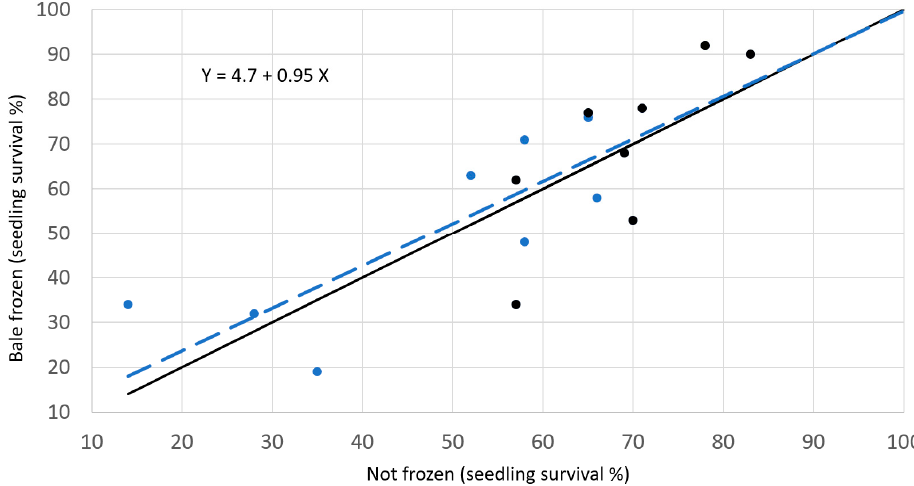
Figure 31. Seedling survivals for genetically unimproved bareroot loblolly pine packed into bundles (2000 seedlings per bail) in January of 1970 at the New Kent nursery in Virginia. Data from [197]. Bales were naturally frozen ( − 11 to − 12 ◦ C) outdoors on January 19 and 20 (blue dots), or February 1 to 3 (black dots). Frozen seedlings were thawed in an unheated building (beginning 23 January or 8 February) and outplanted 34 to 48 days after lifting. When planted in February, survival averaged 69%, and freezing made no difference to survival. When planted in January, non-frozen and frozen seedlings averaged 47% and 50%, respectively (LSD 05 = 10.8 %; two-tailed test). Points >8% below the solid line represent cases where freezing reduced survival. p > |t| = 0.68 for intercept and 0.002 for slope; R 2 = 0.65.